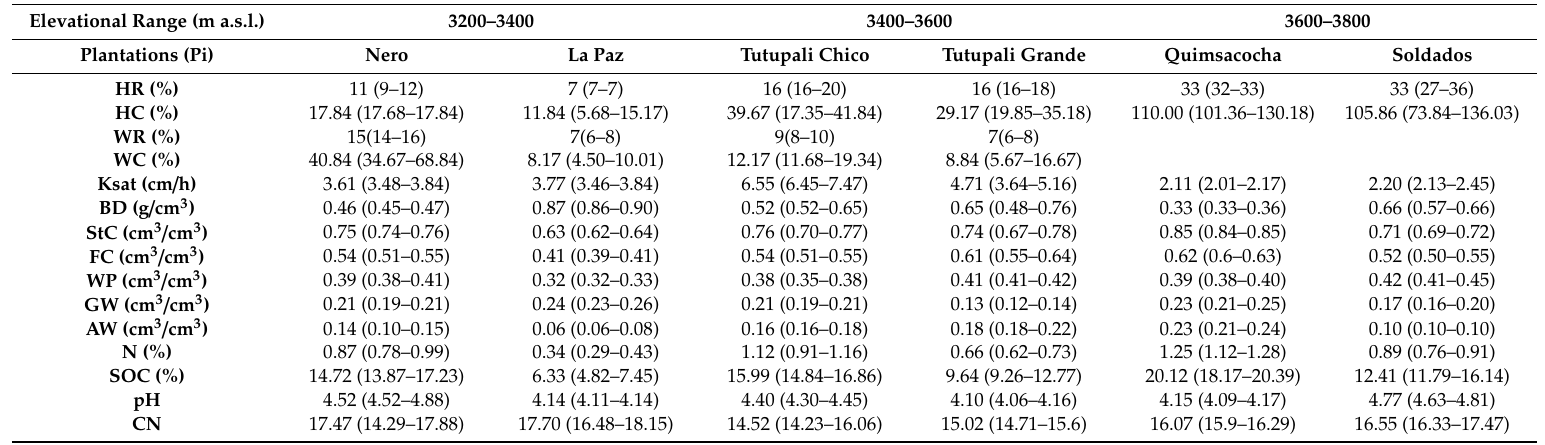
Table A2. Species richness and coverage, and soil properties of pine plantations (Pi) sites across the elevational range. The data indicate the median and between parentheses quartiles (Q1 and Q3). HR = herbaceous richness, HC = herbaceous cover, WR = woody plant richness, WC = woody plant coverage, Ksat = saturated hydraulic conductivity, BD = bulk density, StC = water content at saturation point, FC = water content at field capacity, WP = wilting point, GW = gravitational water, AW = available water capacity, N = nitrogen, SOC = soil organic carbon, pH = potential of hydrogen, CN = carbon-nitrogen ratio. Elevational Range (m